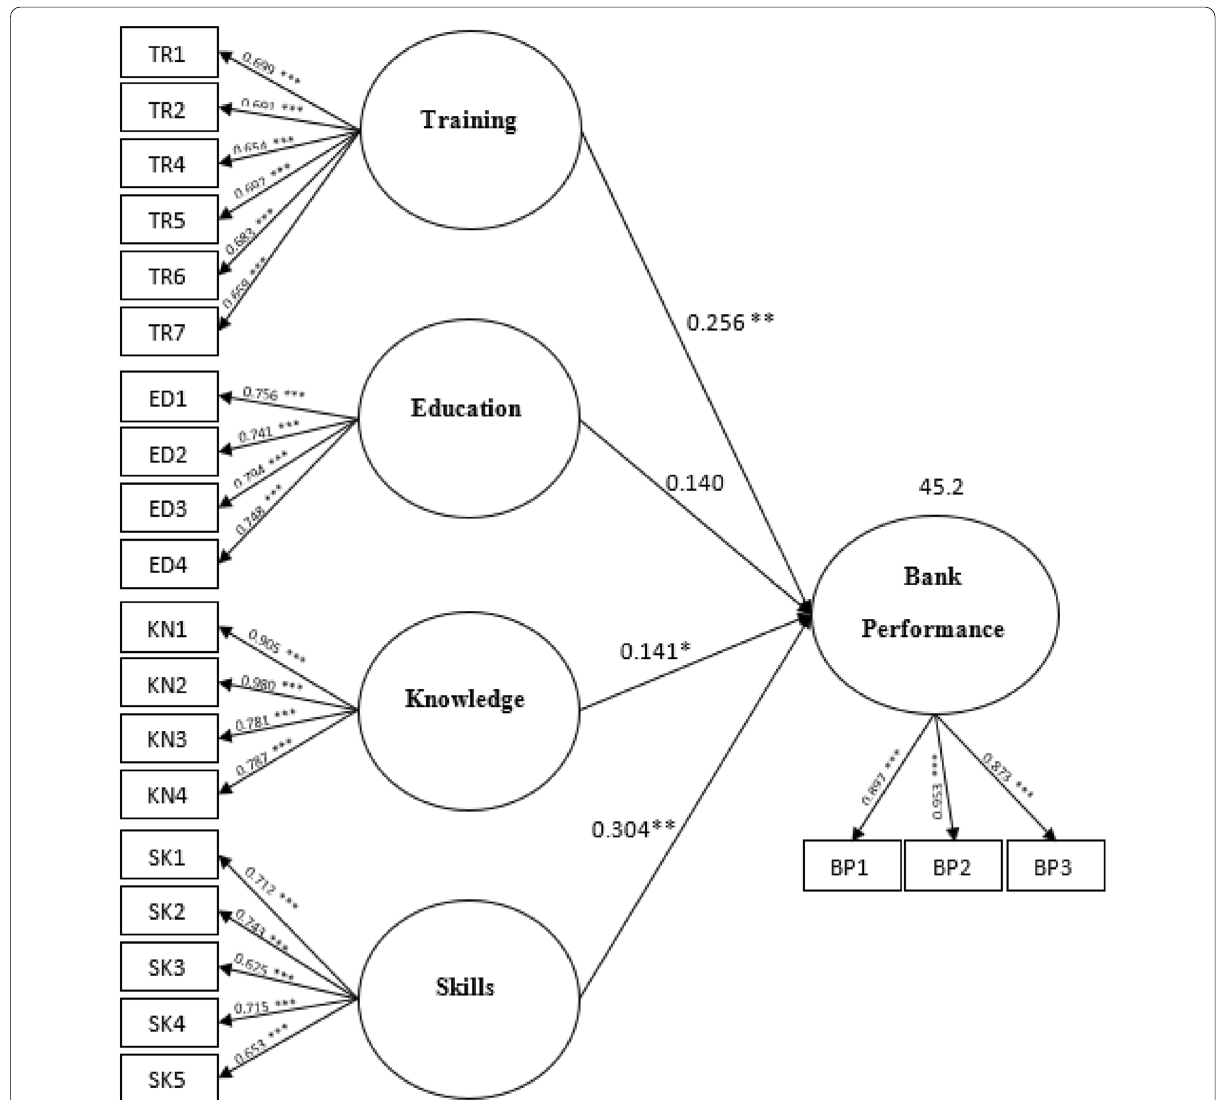
Fig. 2 The structural equation model. *** p < 0.001, ** p < 0.01, * p < 0.05, SEM model fit: χ 2 (199) SRMR 0.06. R-square =